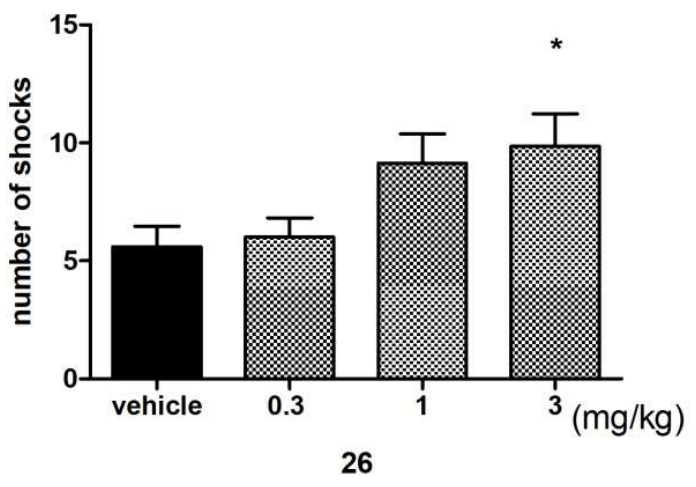
Figure 4. Compound 26 increases the number of shocks accepted in the Vogel conflict test in rats. Compound 26 was administered i.p. 60 min before the test. The animals were monitored for 5 min. The data are presented as the mean ± SEM of 6–8 rats. The data were statistically evaluated by one-way ANOVA followed by Bonferroni’s post-hoc test, * p < 0.05 vs. vehicle group.